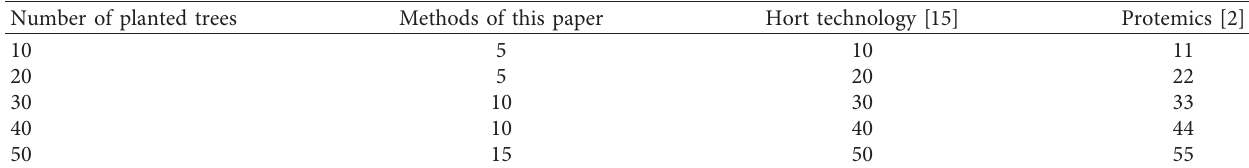
Table 3: Analysis of planting area of sample fruit trees under different techniques (m 2